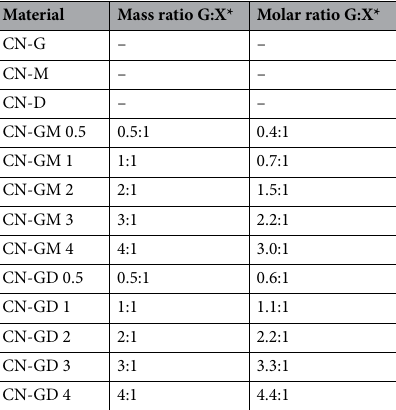
Table 1. Mass and molar ratio of CN materials. *X stands for melamine (M) and dicyandiamide